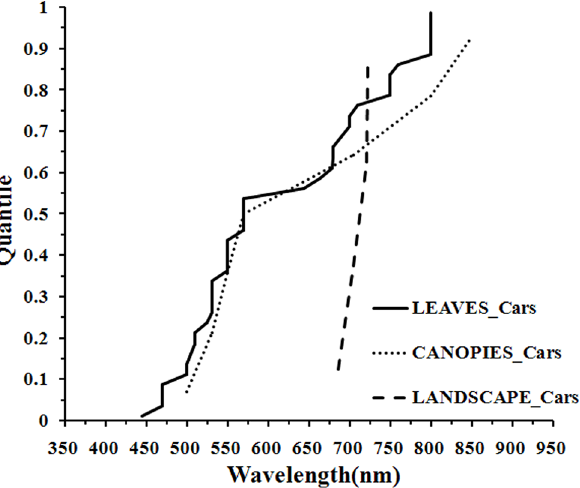
Fig 11. Quantile plot of the optimal wavelength for the quantification of Cars at different scales.